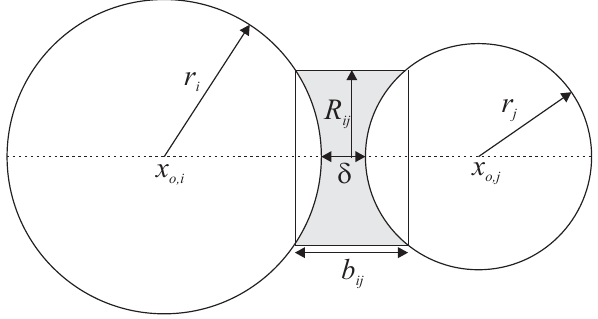
Figure 2. Geometry of two grains, i and j , connected with a semi- elastic